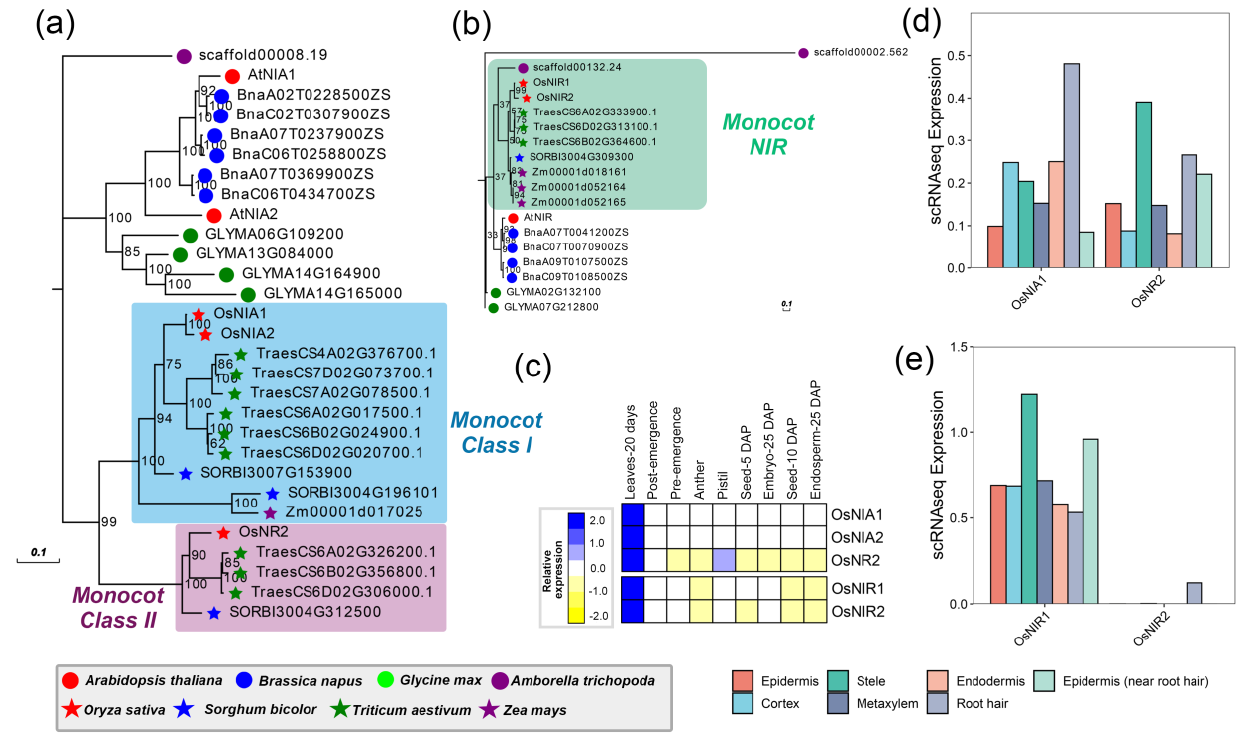
Figure 1. The phylogenetic analysis and expression pattern of NR and NiR superfamily. ( a , b ) represent the phylogenetic trees of the NR and NiR superfamily, respectively. The red, blue, and green circle dots represented the three monocot species, including A. thaliana , B. napus , and G. max . The purple circle dots indicated the outgroup A. trichopoda . By contrast, the stars of red, blue, green and purple indicated these genes from four monocots, containing O.sativa , S. bicolor , Triticum aestivum , and Z. mays , respectively. ( c ) indicates the expression heatmap of NR and NiR superfamily among nine tissues. The tissues names of Nipponbare represent as follows: Leaves-20 days: leaves at 20 days; Post-emergence: emerging inflorescence; Pre-emergence: Early Inflorescence; Anther: anther; Pistil: pistil; Seed-5 DAP: seed five days after pollination; Embryo-25 DAP: embryo 25 days after pollination; Seed-10 DAP: seed 10 days after pollination; Endosperm-25 DAP: endosperm 25 days after pollination. The color bar means that the expression was high with the blue color, while it was expressed at a low level with the yellow bar, and ( d , e ) mean the expression of NR and NiR superfamily through the single-cell transcriptome data of roots in rice. The bars with different colors represent the different types of cells of roots.